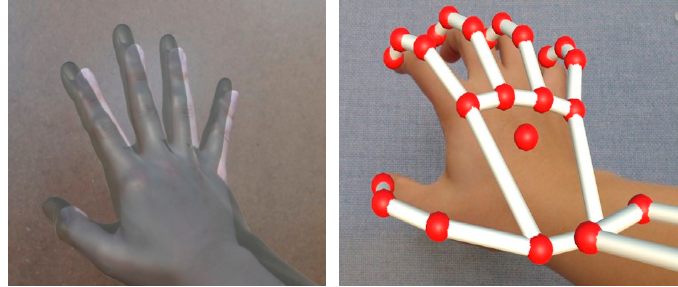
Figure 10. Actual hand detection and calibration with the virtual hand in the wearable AR.